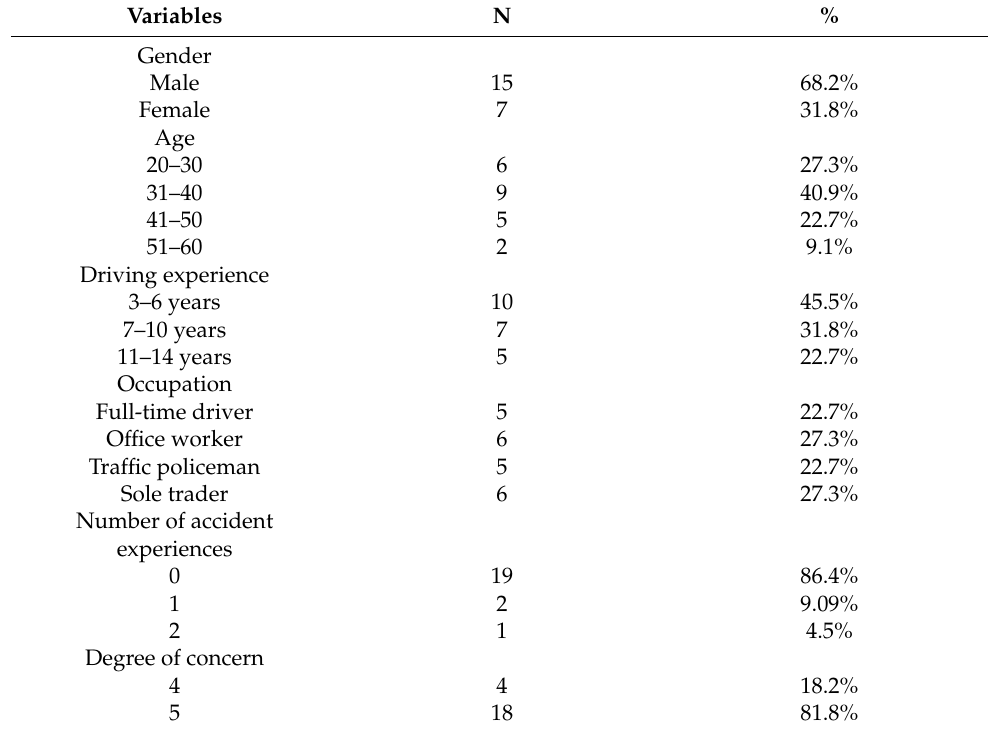
Table 1. Summary statistics of demographic